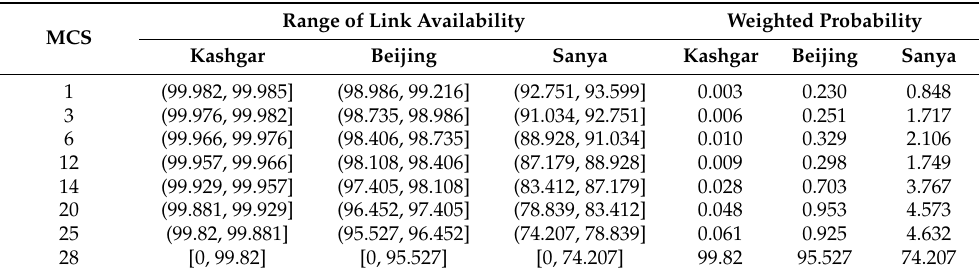
Table 7. Theoretical range of link availability and weighted probability of each MCS in ACM system at 5 ◦ elevation angle